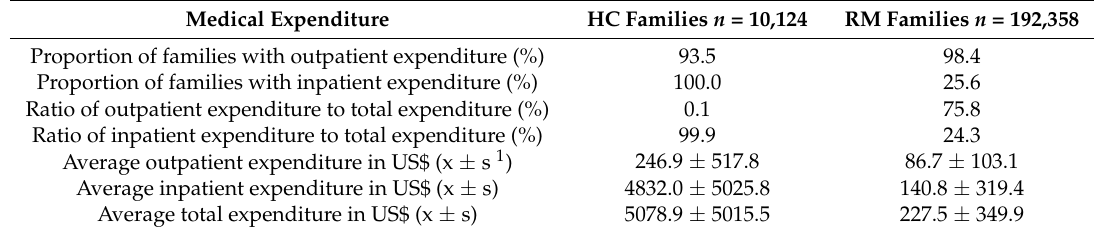
Table 2. Medical expenditure of different family groups in Macheng in